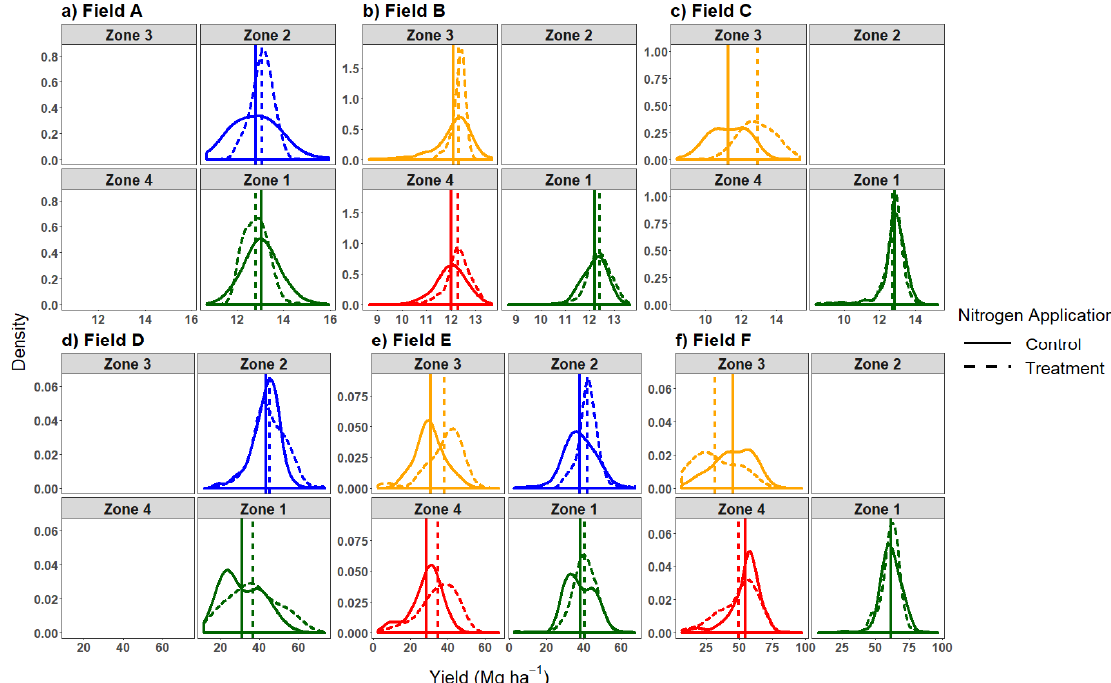
Figure 4. Density plots representing corn yield distribution of N treatment and control strips in individual fields, with up to four yield stability zones, as per Kharel et al. [15] . The dotted and the solid vertical line represent the average yield for the treatment and control strip, respectively. Fields A,B,C ( a , b , c ) were harvested for grain. Fields D,E,F ( d , e , f ) were har- vested for silage.